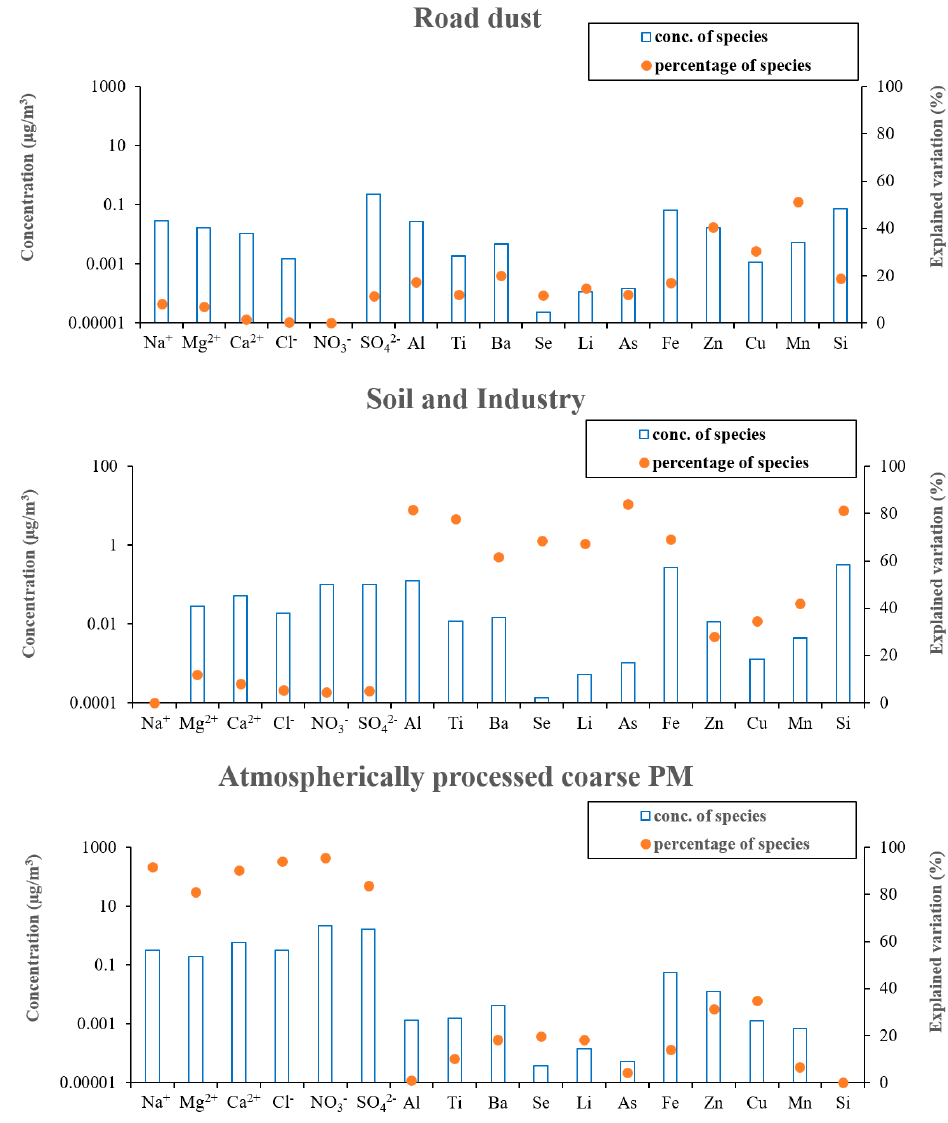
Figure 5. PMF resolved factor profiles.